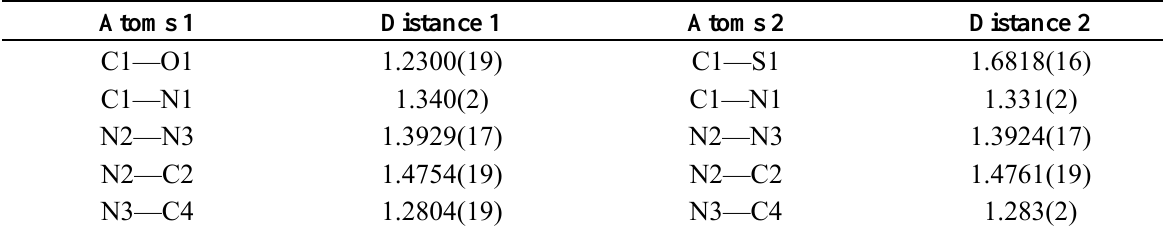
Table 1. Selected atom distances [Å] for 1 and 2